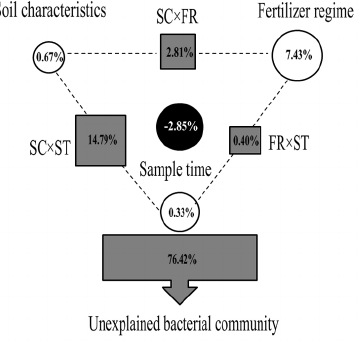
Figure 3. Variation partitioning analysis of the bacterial communities. Effects of soil characteristics (SC), fertilizer regime (FR), sample time (ST) and the interactions between them on the bacterial community structure. Circles on the edges of the triangle show the percentage of variation explained by each factor alone. The percentage of variation explained by interactions between two or three of the factors is shown as squares on the sides and as circle in the center of the triangle. The unexplained variation is depicted in square on the bottom.